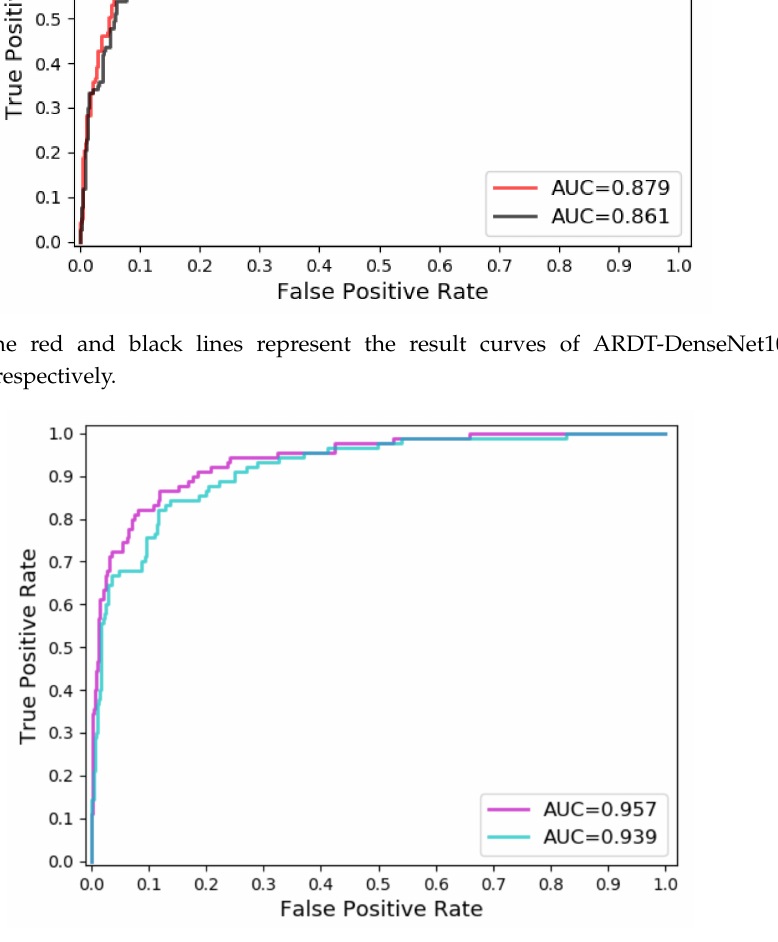
Figure 7. The pink and blue lines represent the result curves of ARDT-DenseNet and DenseNet100,